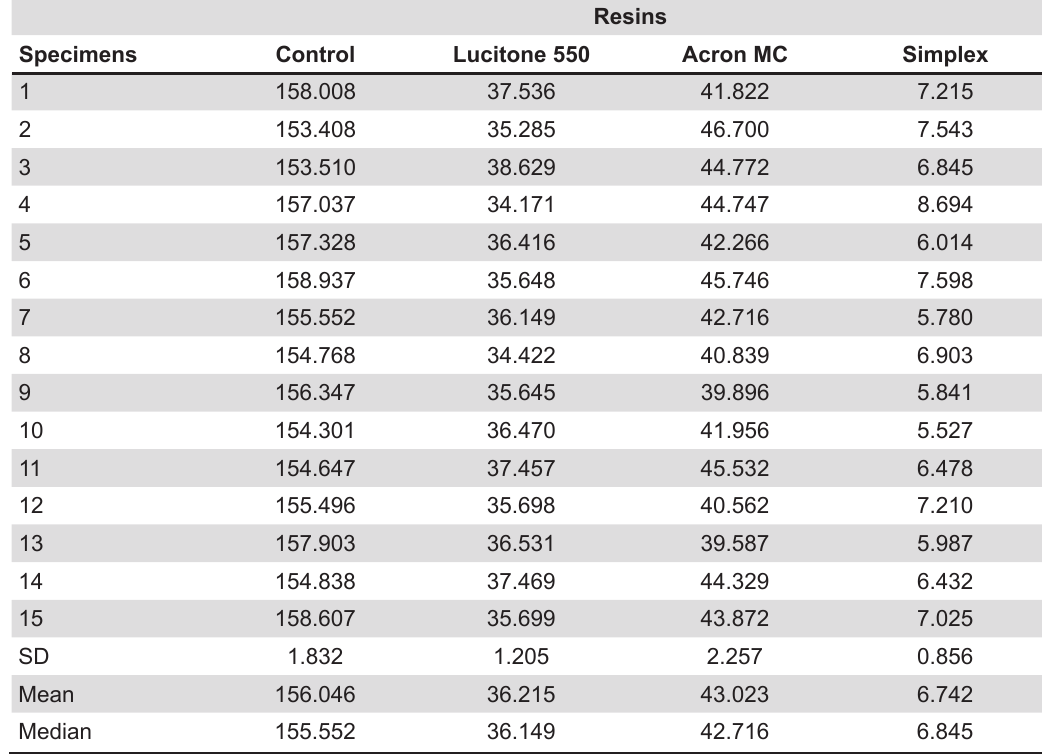
Table 1- Measurements of rupture tension in the MPa, standard deviation (SD), mean and